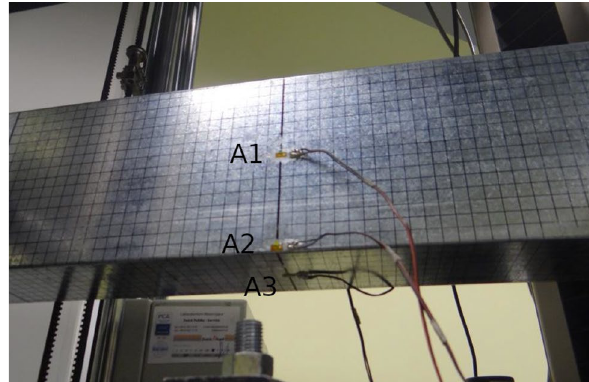
Figure 6. Strain gauges connected to the specimen web and flange.